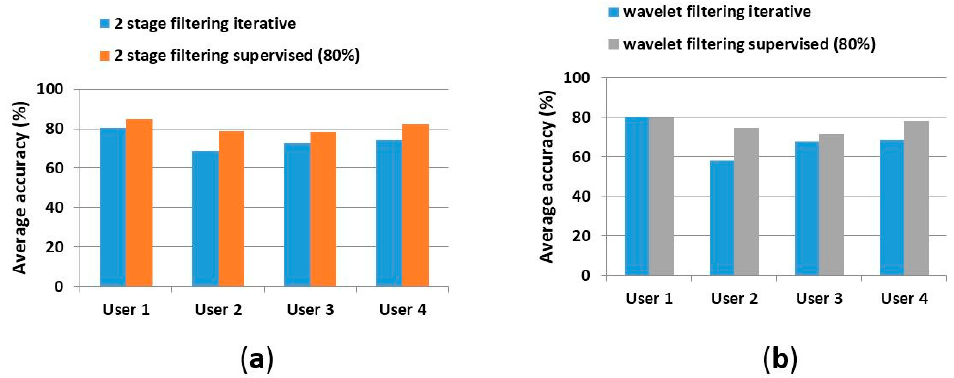
Figure 8. Average accuracy comparison between single-stage and two-stage filtering. ( a ) average accuracy when using two-stage filtering and the iterative methodology (in blue) and when using the supervised method (in red); and ( b ) average accuracy when using the single-stage (wavelet filtering) solution and iterative methodology (in orange) and when using the supervised method (in purple).